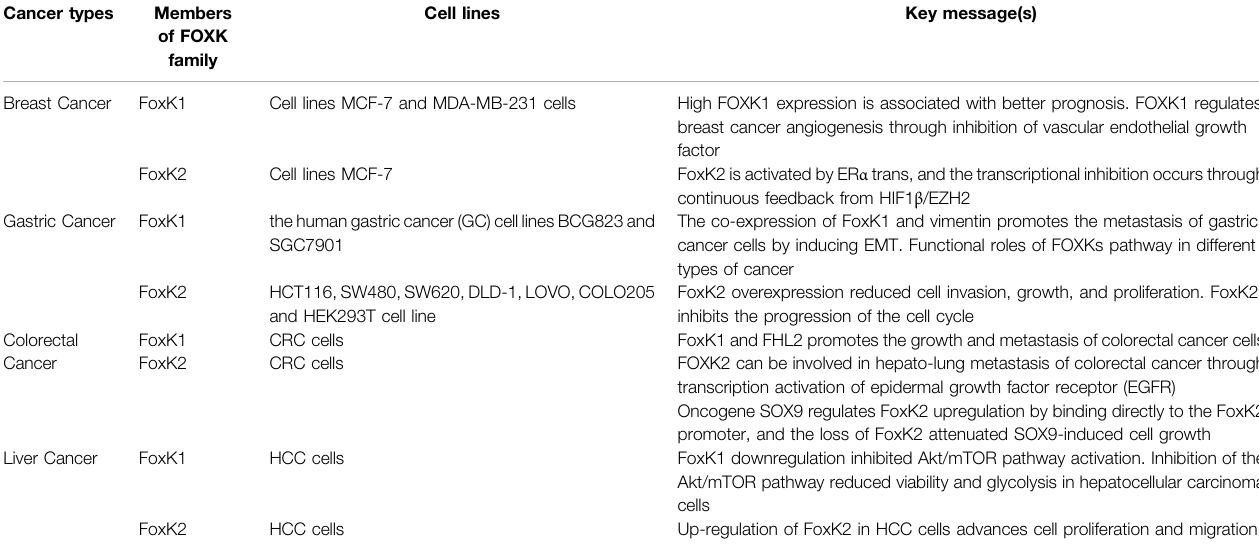
TABLE 1 | Functional roles of FOXKs pathway in different types of cancer. Cancer